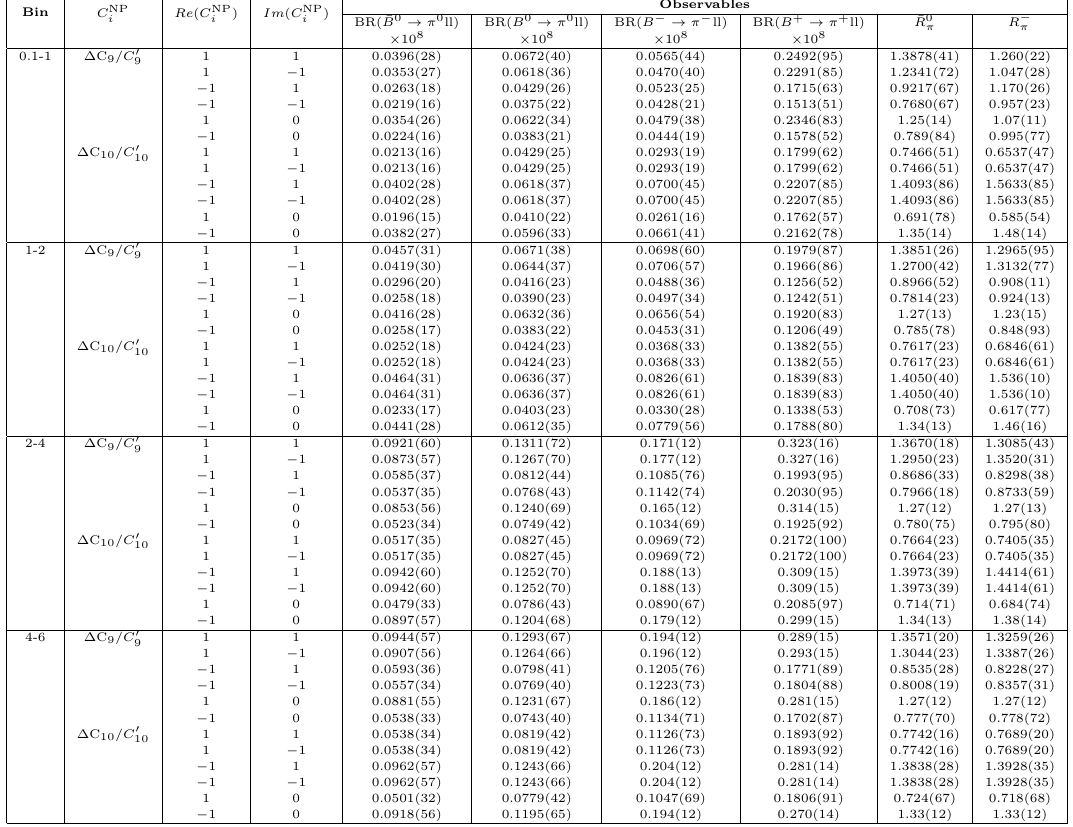
Table 19 . The dependence of the Branching ratio and R π on the NP WC’s ∆ C 9 , 10 and C 0 the q 2 bins 0 . 1 − 1 , 1 − 2 , 2 − 4 and 4 − 6 GeV 2 for a few benchmark values of the real and imaginary parts of the corresponding WC’s. The − , 0 superscript over R state B and the final state π